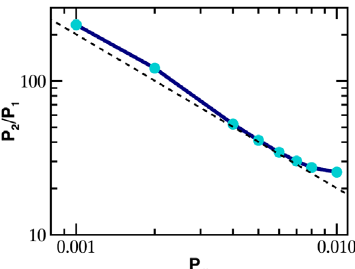
Fig. 7. Variation of the ratio between the long-term modulation period ( P 2 ) and the primary magnetic cycle period ( P 1 ) versus the magnetic Prandtl number (Pm). Except for the latter, all solutions use the same parameter values as solution 3 in Table 1 (see also Fig. 6). The dashed line indicates a Pm (cid:3) 1